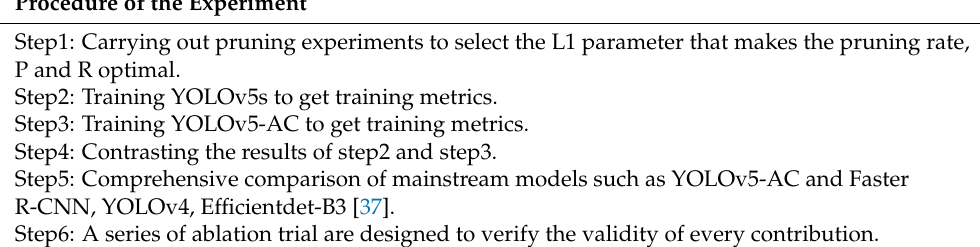
Table 2. Procedure of the